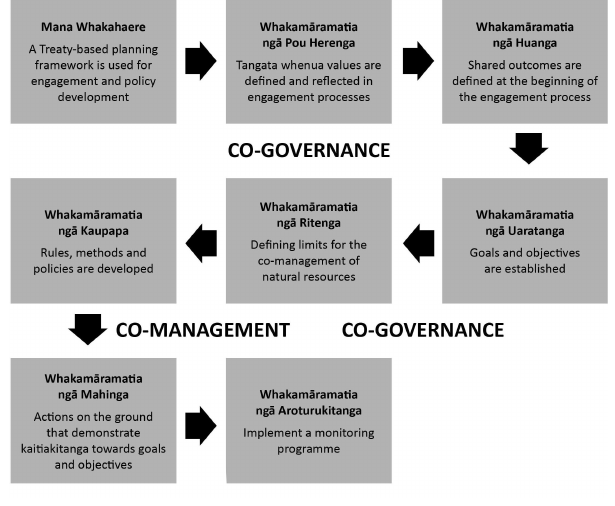
Fig. 1 . An eight-step tikanga process to achieve desired freshwater planning and management outcomes for M ā ori (Robb et al.